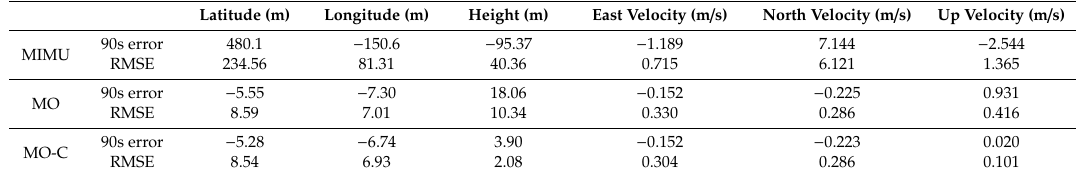
Table 2. Positioning and velocity error comparison.